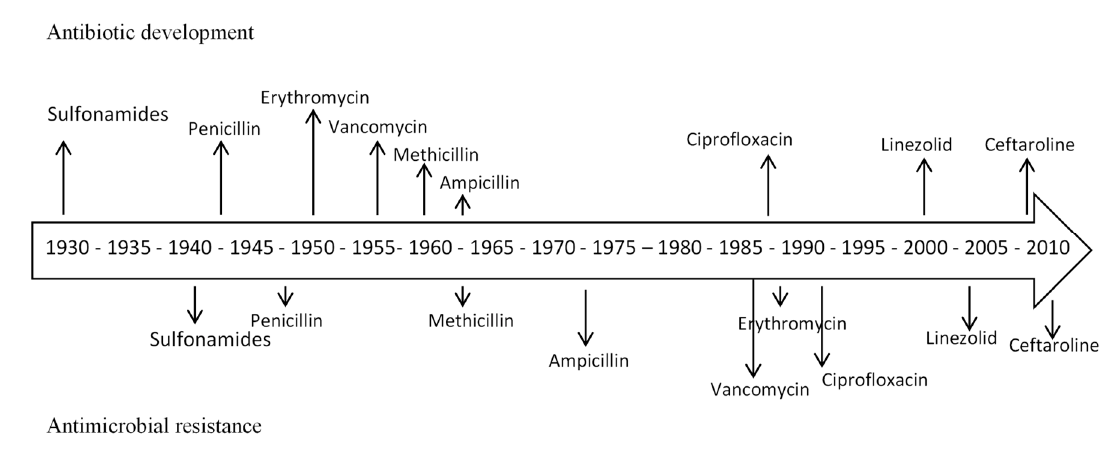
Figure 1. Development of antibiotics and appearance of bacterial resistance over time.